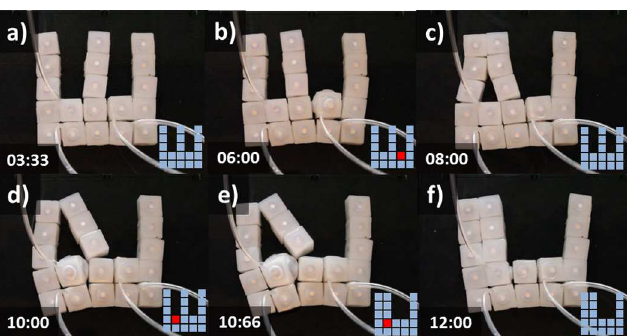
Fig 15. Self-Reconfiguration on setup 2A-17U, Second Actuation Pattern. Secondpart demonstrating how varying actuationpattern results in different configurations. A group of 19 modulesis initiallyconfigured into the same ‘E’ shape(a) as in Fig 14A. In this case the lower-rightmodule is first inflated (b) and then the lower-left module is inflated (d,e). This invertedactuationpattern results in a different ‘C’ shape. Time stamps are in the format